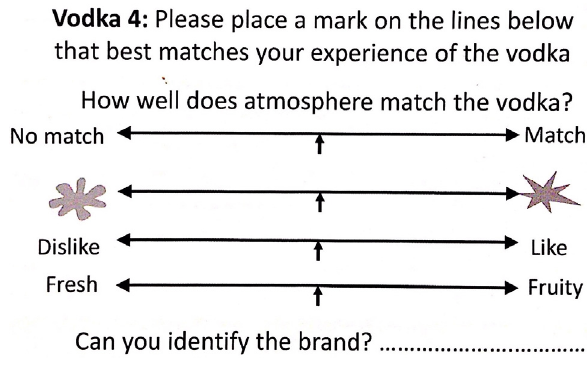
Figure 1. A sample questionnaire given to the participants in the present